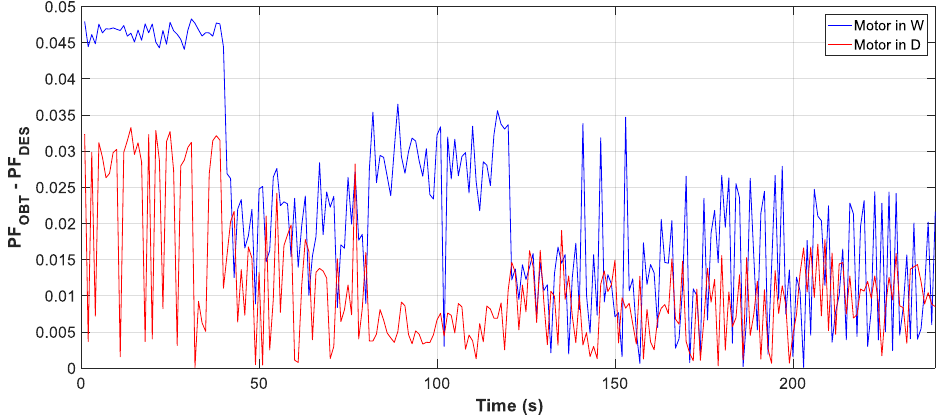
Figure 9. Difference between PF OBT and power factor desired (PF DES ).